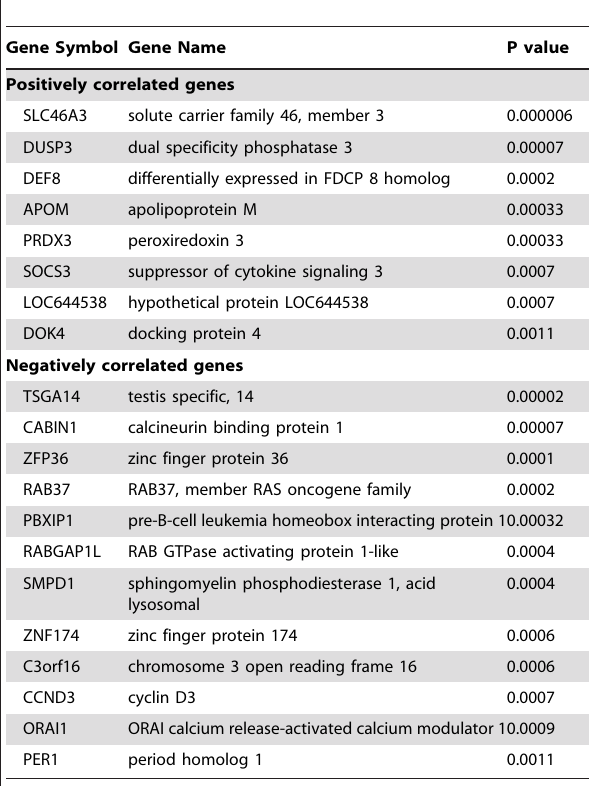
Table 2. Correlation coefficients of peripheral blood cell gene expression with visceral fat